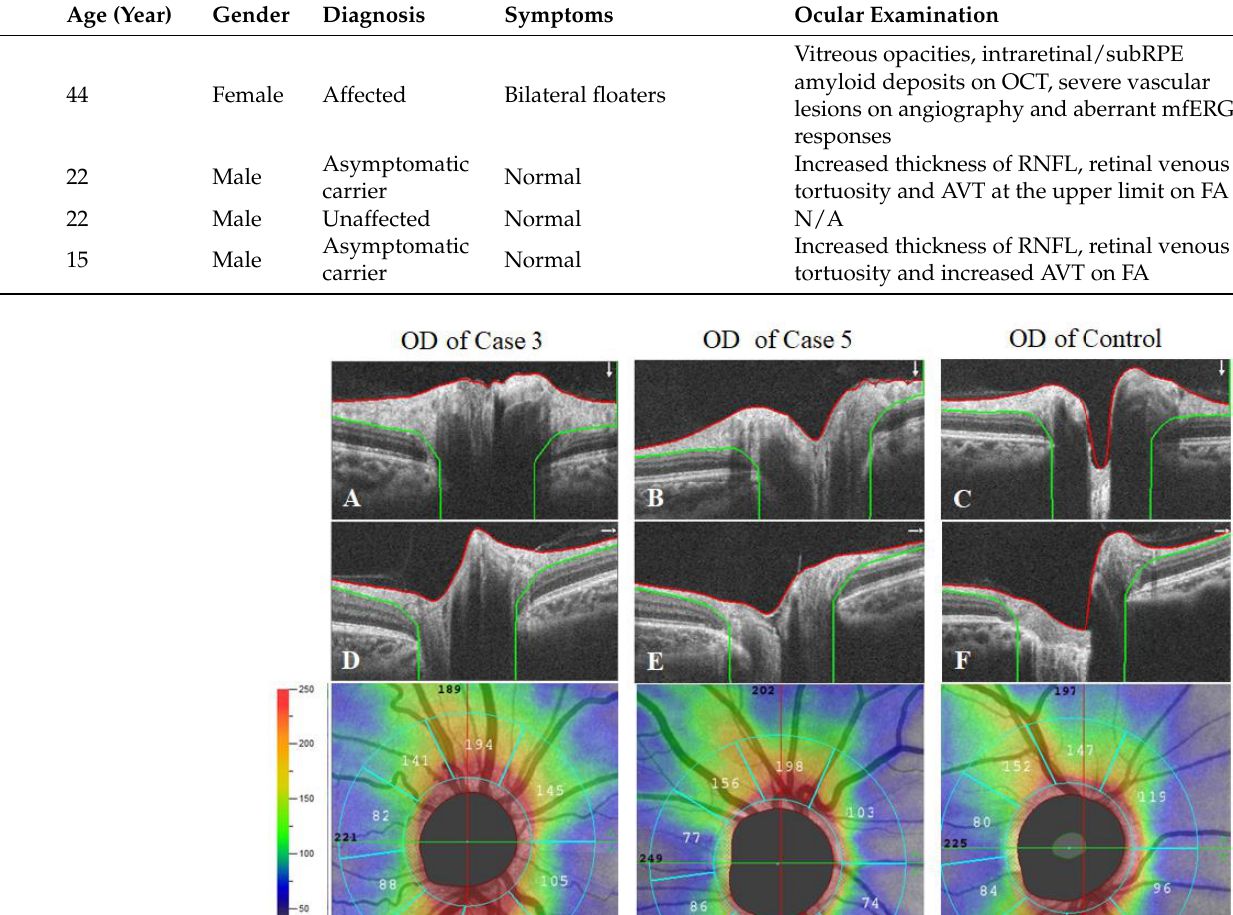
Table 1. Summary of the clinical information of the family members included in the study.